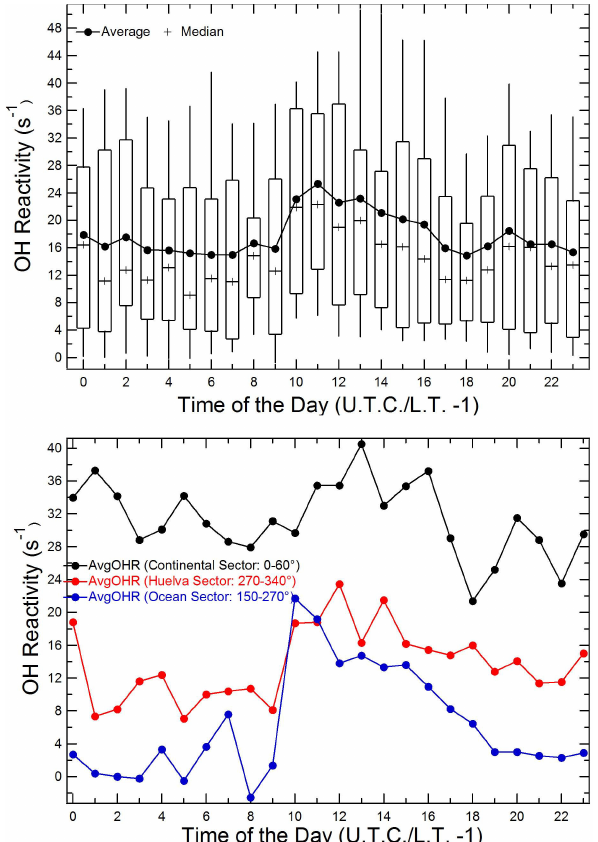
Fig. 3. (a) and (b) Diel box and whisker plot of the total OH re- activity at Base de Arenosillo (37 ◦ 05 0 58 00 N, 6 ◦ 44 0 17 00 W) derived from all measurements ( n > 11500) during the DOMINO cam- paign (top) and average diel profile of OH reactivity for air masses from the Continental (black), Huelva (red) and Ocean (blue) wind